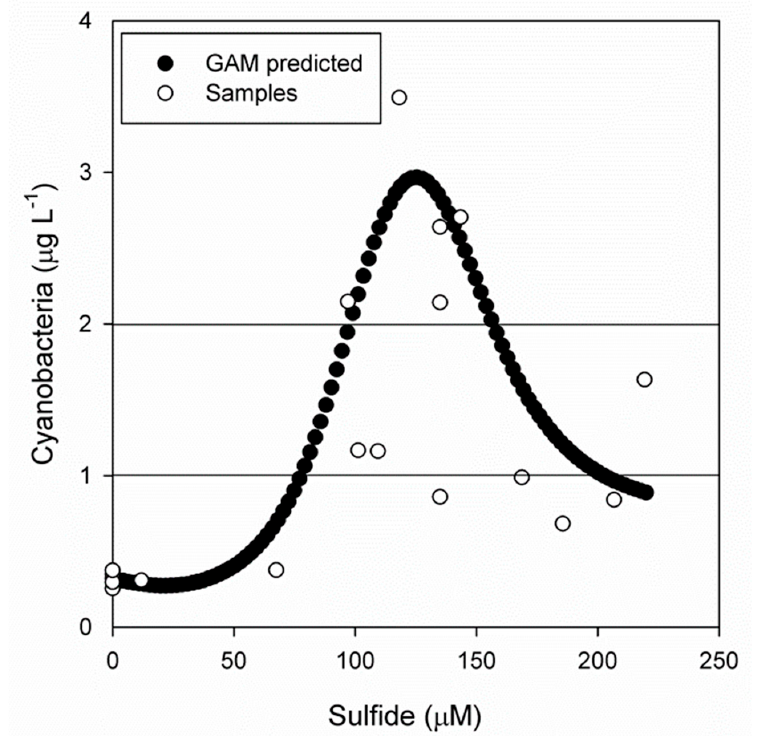
Figure 6. Prediction of cyanobacteria concentration as a function of sulfide concentration at La Hedionda spa as derived from the general additive model (GAM).